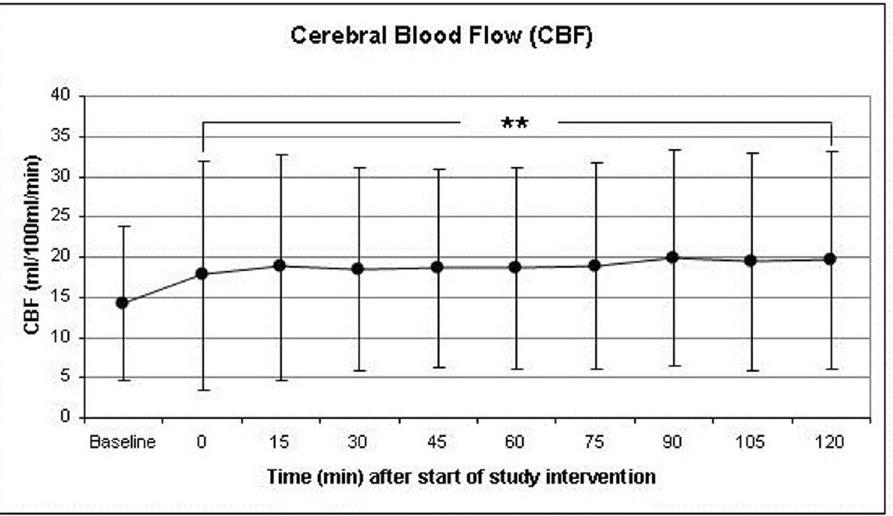
Figure 5. The course of cerebral blood flow (CBF) during the study intervention was measured by a right frontal intracerebral thermodilution probe. (*p < 0.05, **p < 0.01, ***p < 0.001). Data presented as Mean ± SD; 1-way ANOVA for Repeated Measurements; *p < 0.05, **p < 0.01, ***p < 0.001, plots and error bars presented as Mean ± SD (standard deviations).